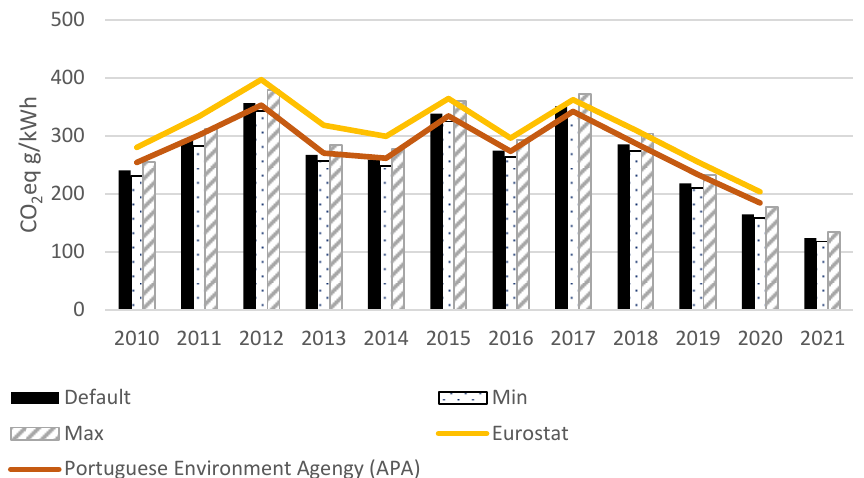
Figure 6. CO 2 eq emission factors according to own simulation, Eurostat ([28]) and APA [27].